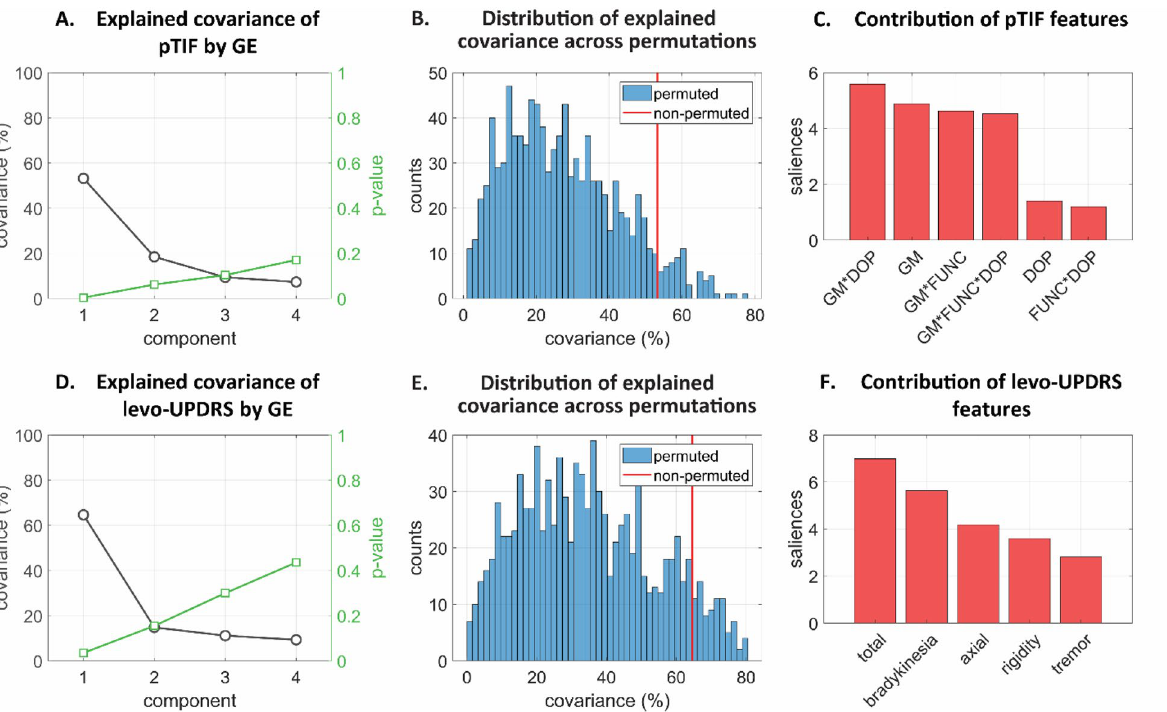
Figure 5. Multivariate cross-correlation results between GE, imaging-derived therapeutic needs and levodopa- induced clinical effects. ( A ) Explained covariance of pTIF by GE for the obtained principal components. ( B ) Distribution of explained covariance across randomized permutations for PC1. ( C ) Contribution of pTIF features in PC1. ( D ) Explained covariance of levo-UPDRS by GE for the principal components. ( E ) Distribution of explained covariance across permutations for PC1. ( F ) Contribution of levo-UPDRS features in